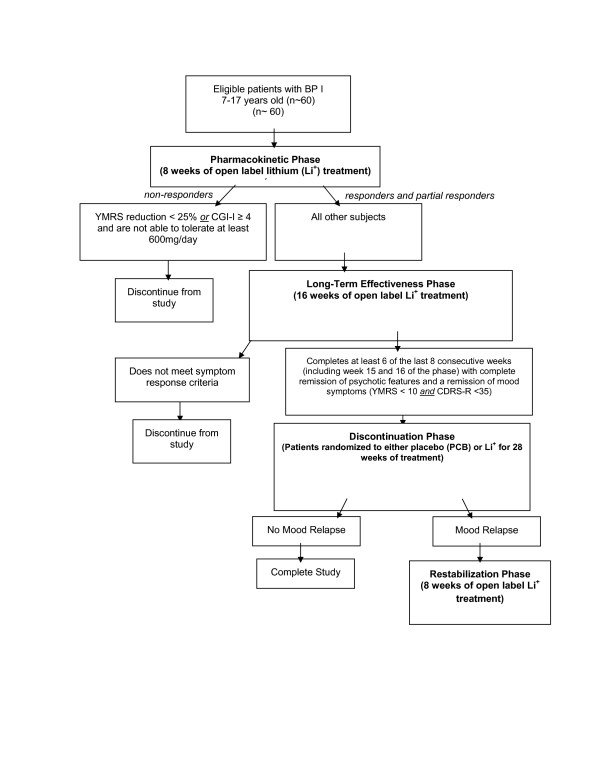
Study 1 of CoLT.